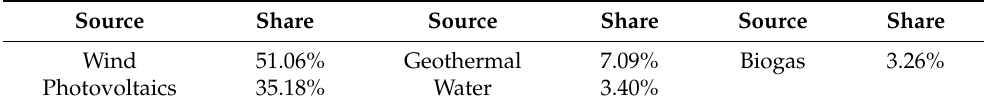
Table 8. Shares of power grid mix of 100% renewable energy